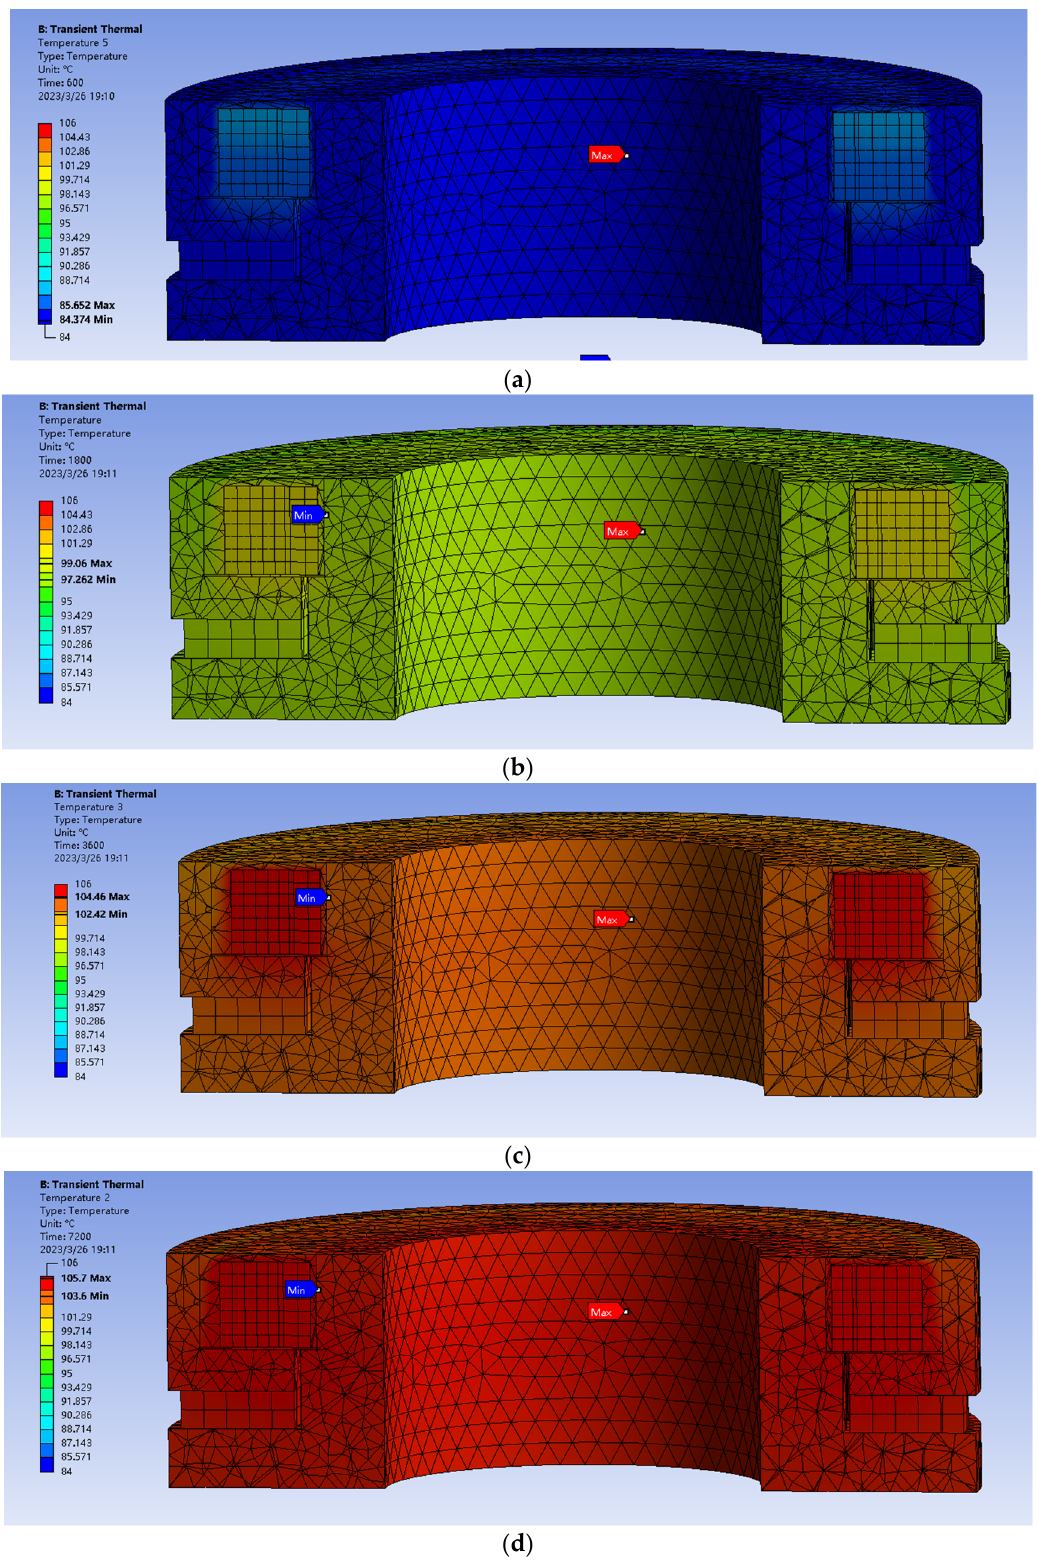
Figure 6. Temperature distribution in the time period. ( a ) Brake temperature distribution at 600 s. ( b ) Brake temperature distribution at 1800 s. ( c ) Brake temperature distribution at 3600 s. ( d ) Brake temperature distribution at 7200 s.